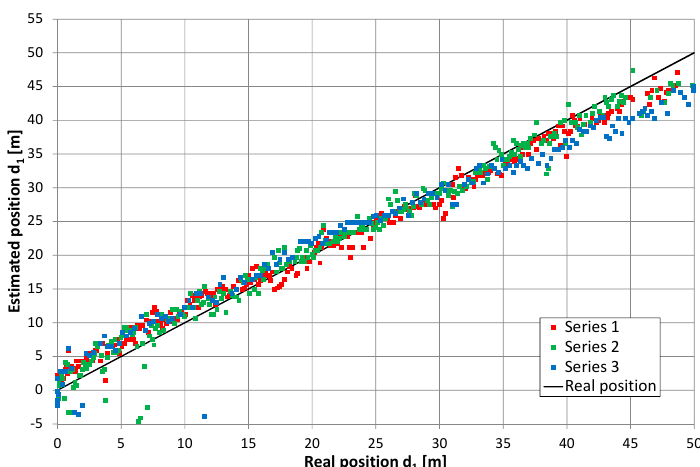
Figure 11. Results of position estimation in the case of return signal frequency conversion; the height of receiving antenna: 0.3 m, series 1–3.